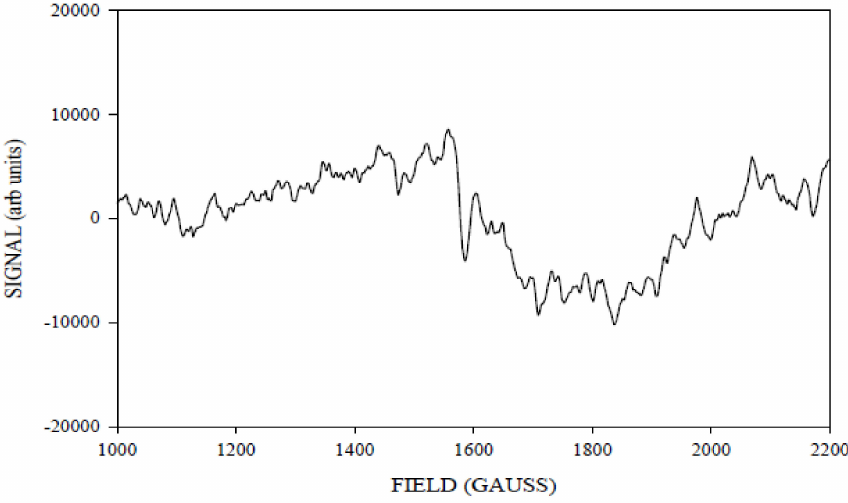
Figure 6. The X-band CW-EPR difference g 4.1 spectrum obtained corresponding to the light ( ≈ 240 K illumination) minus annealed spectra. Spectrometer conditions: 15 G modulation amplitude, center field 1650 G, sweep width 2500 G, 0.2 mW microwave power, frequency 9.370369 GHz, temperature 6 K, number of points 2500.